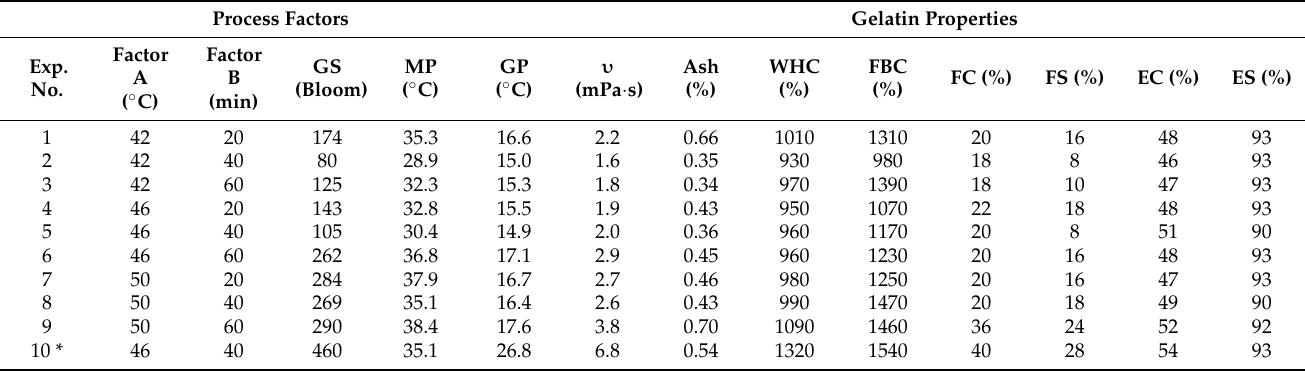
Table 4. Results of the analysis of the properties of the second gelatin fractions.